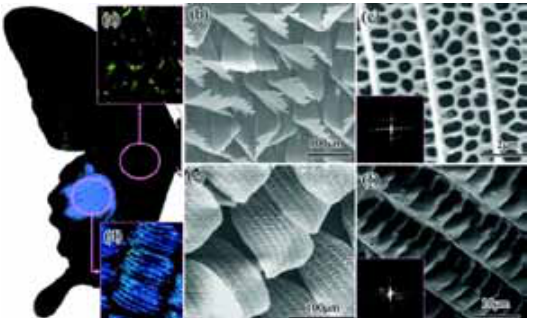
Fig. 17 Nature picture and low-magnification optical microscopy, low-magnification FESEM imag- es and high-resolution FESEM images show- ing the wing of the blue male (a - c) and black male (d - f). The insets in the lower left-hand (c, f) corner show the two-dimensional, loga- rithmic Fourier power spectra of square areas selected from the